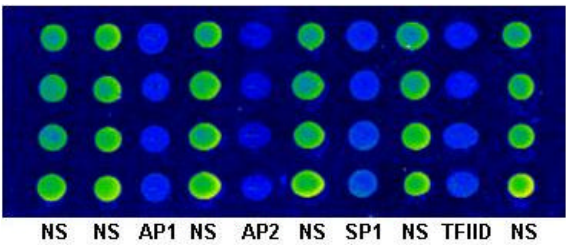
Figure 4. Fluorescence image of the unimolecular dsDNA microarray containing AP1, AP2, SP1, TFIID and NF- ? B TOs hybridized with Cy3-labeled NF- k B p50